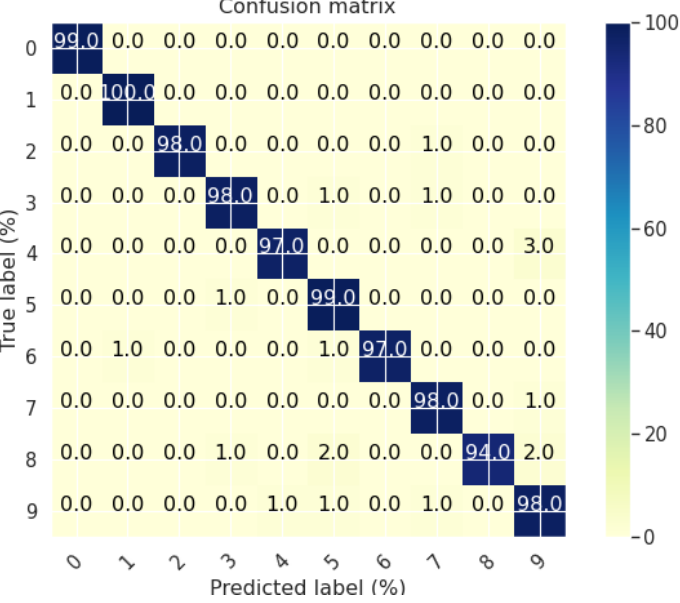
Figure 7. Confusion matrix for Experiment 1: centralized